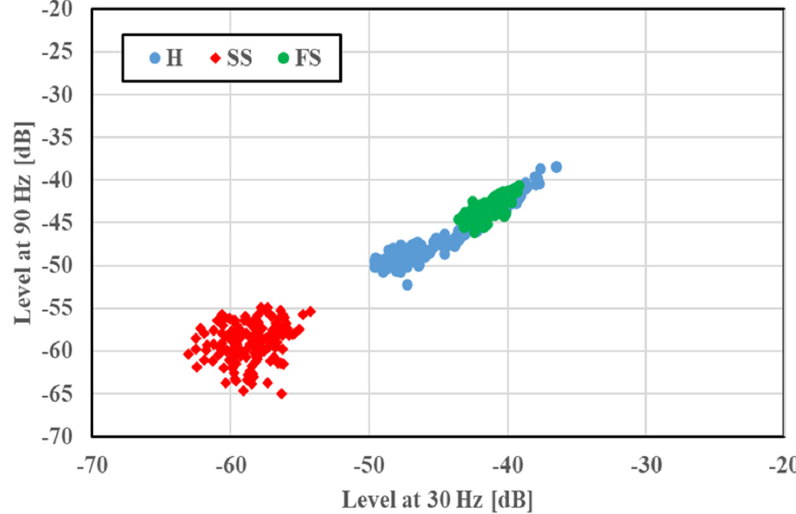
Figure 7. Feature distribution without considering the rotation speed (basic scratch).